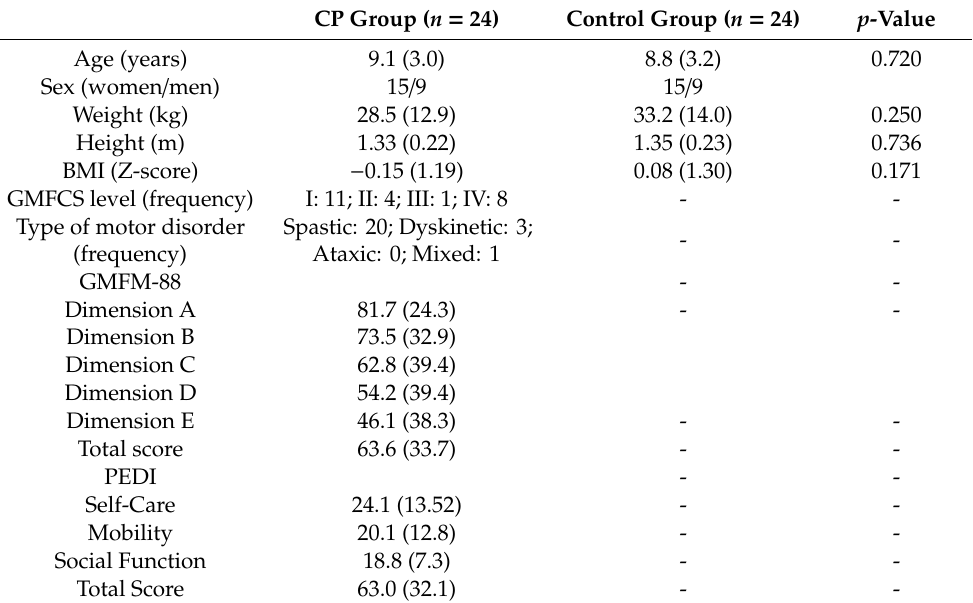
Table 1. Demographic and clinical characteristics of the